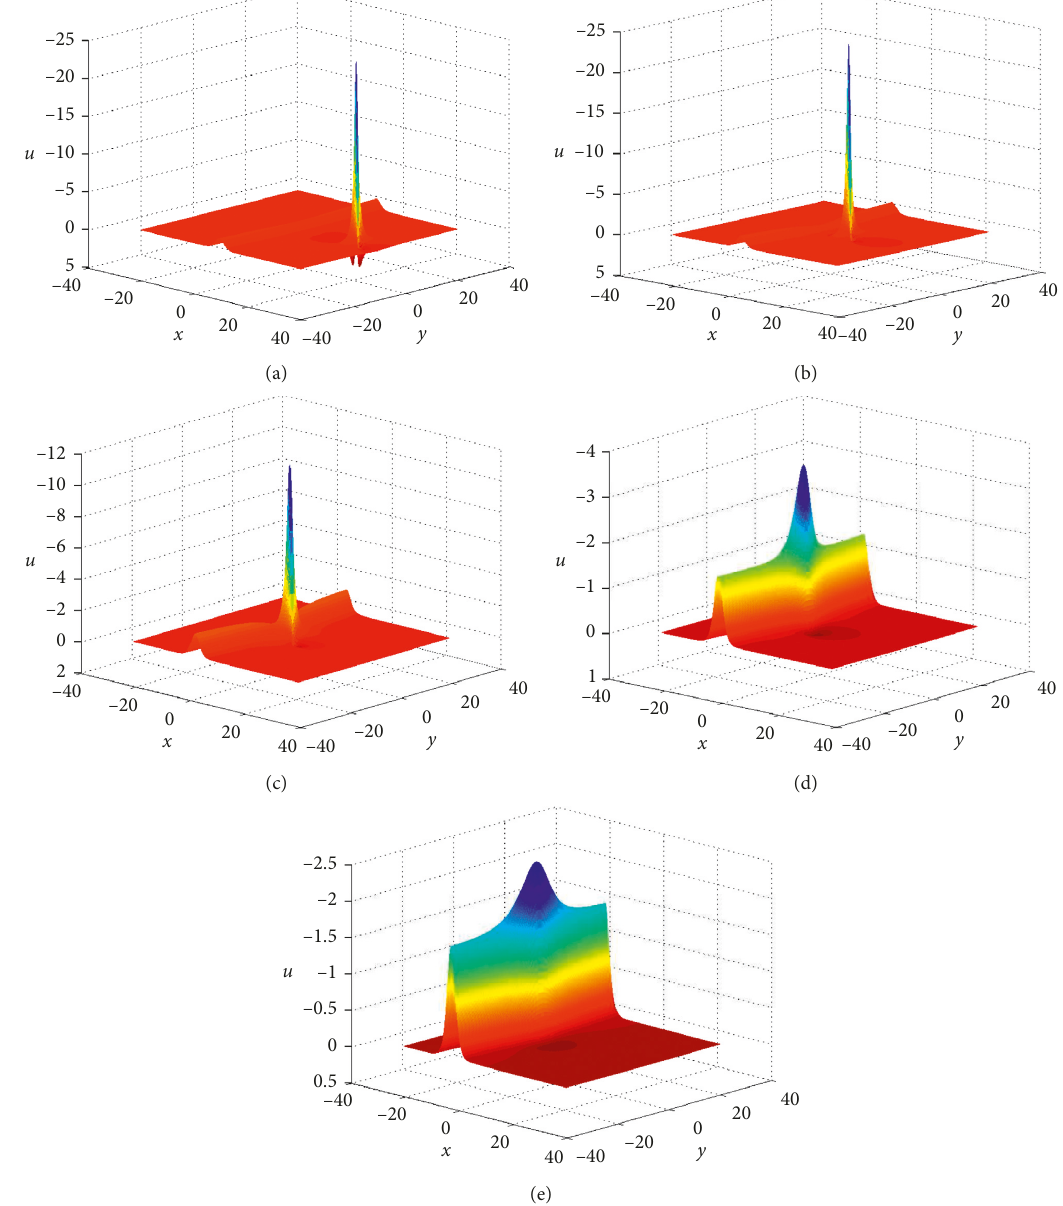
Figure 4: Fusion phenomenon: plots of interaction solutions (15) with α (a) t � − 10; (b) t � − 2; (c) t � 0; (d) t � 2; (e) t �